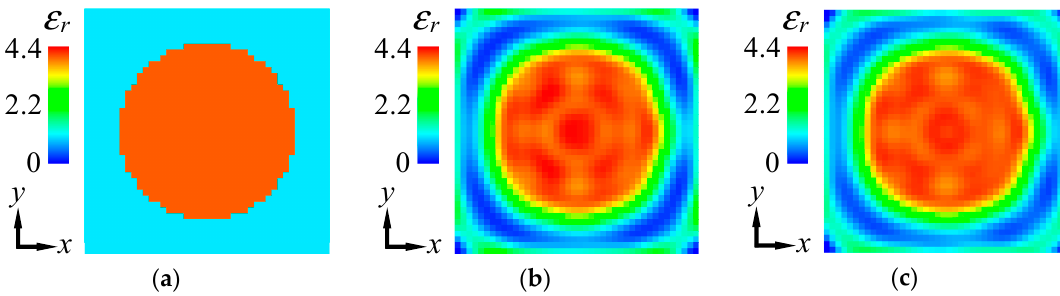
( b ) Figure 10. Error of incident field on x -axis ( M = 200): ( a ) square target and ( b ) L-shape target. 4.2. Reconstruction of Target Object Using Extracted Incident Field In this section, the performance of the proposed method is verified on inverse scattering problems, where relative permittivity ε r is estimated. From the results in the preceding Subsection 4.1, M is set to 200, and the cost functional F is evaluated on the measurement curve C of radius 3 λ . The initial ε r in the reconstructed region is set to 2.0, i.e., initial contrast χ (0) = 1.0. It is assumed that we illuminate the target with the plane wave: